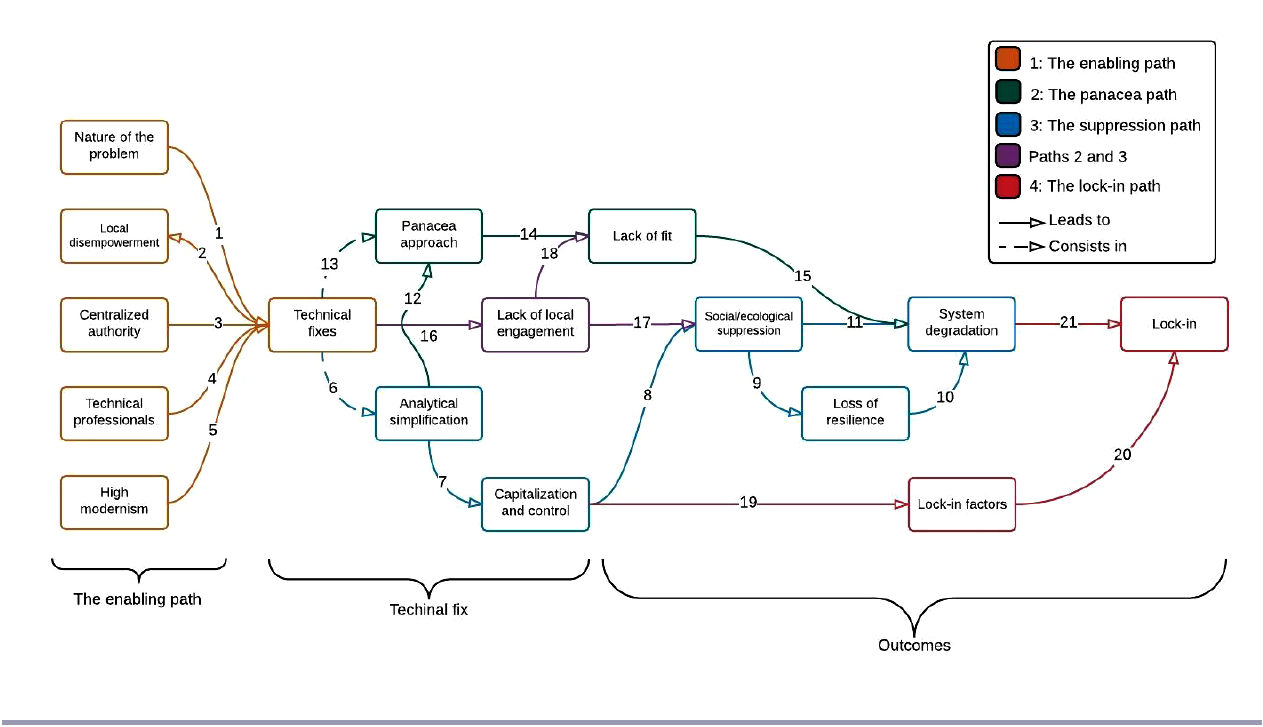
Fig. 1. Formalization of the theory of the pathology of command and